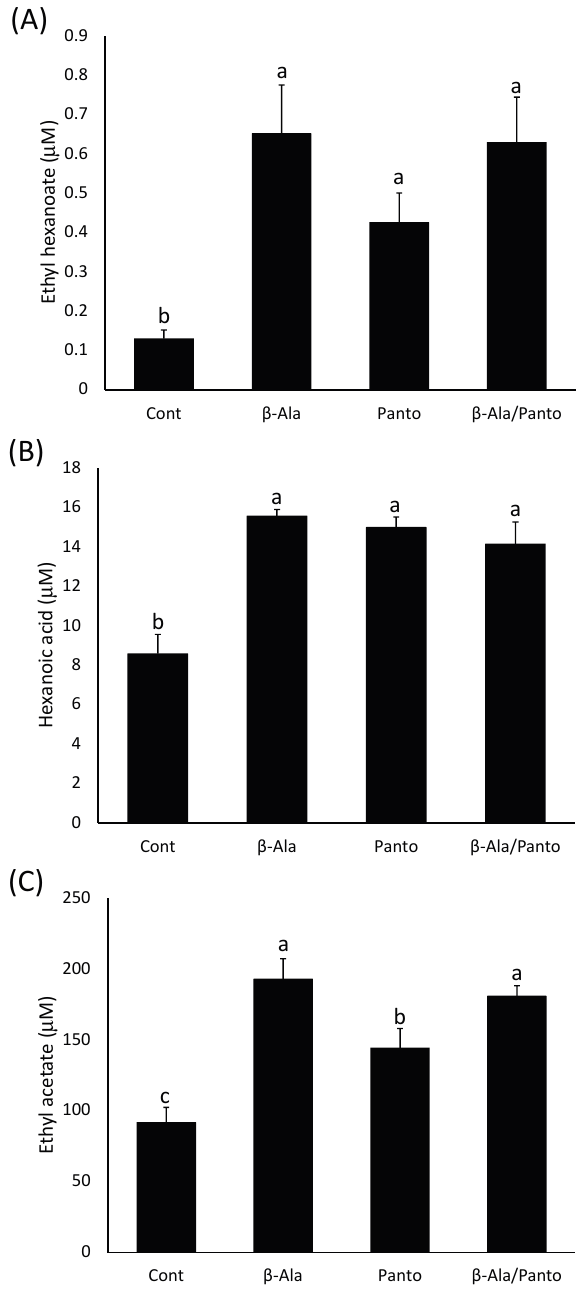
Figure 8. The concentration of ( A ) ethyl hexanoate, ( B ) hexanoic acid and ( C ) ethyl acetate in model wines produced after the addition of β -alanine ( β -Ala), pantothenate (Panto) or both compounds ( β -Ala/Panto) as indicated on the x-axis. Histograms represent the mean values (n = 3) and error bars show standard errors. Different letters (e.g., a, b, c) denote significant differences between treatments at p < 0.05 using ANOVA followed by Tukey’s post hoc